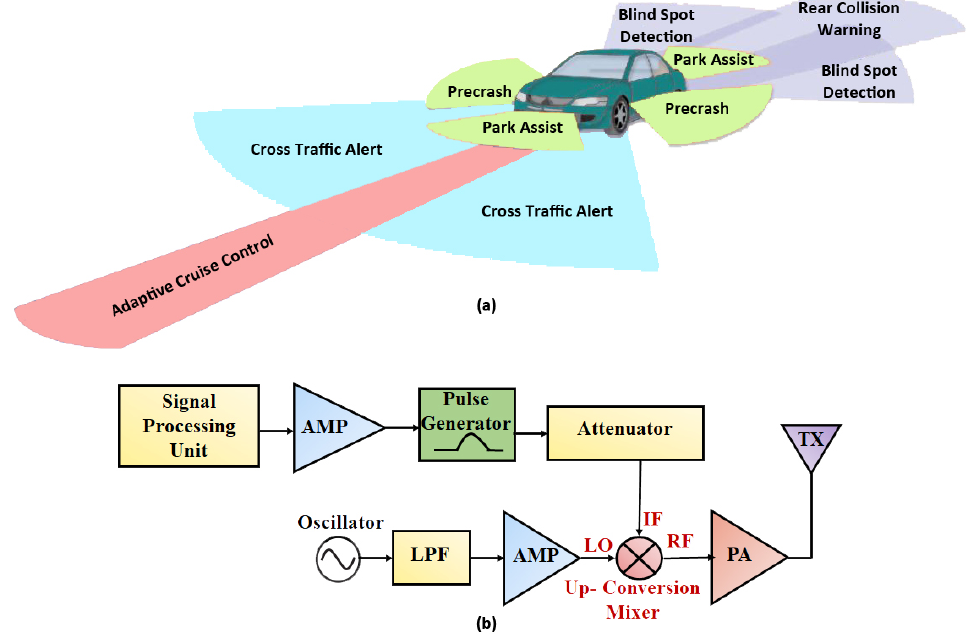
Figure 1. ( a ) Automobile radar application, ( b ) radar transmitter